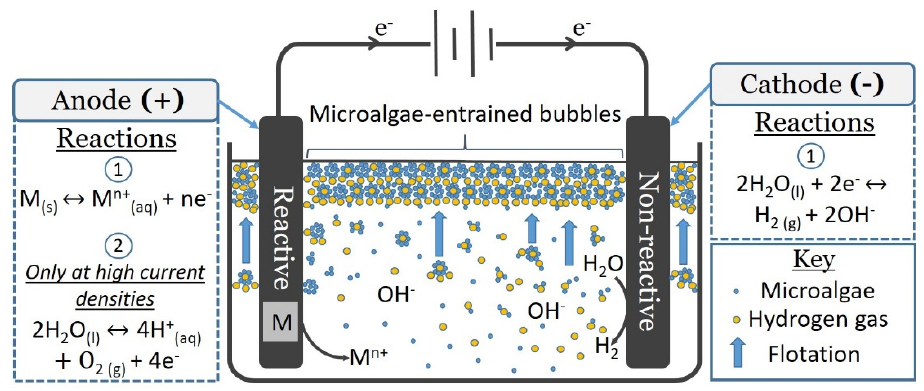
Figure 2. Diagrammatic description of an electroflotation-based microalgal dewatering process. Table 5. Simplified description of the main electrolytic dewatering techniques in microalgal biomass generation.